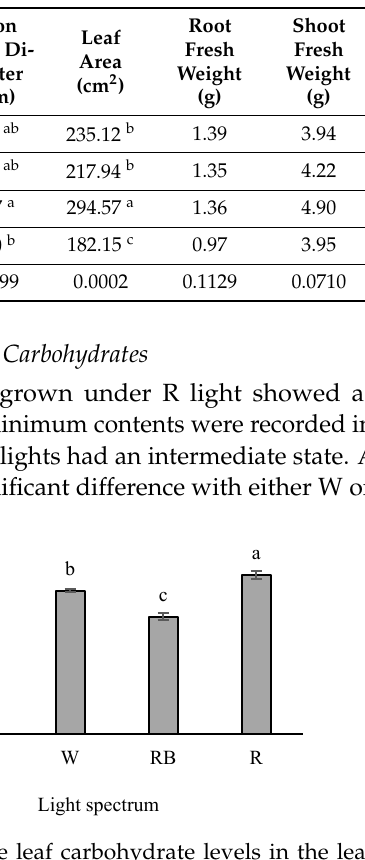
Figure 2. Soluble leaf carbohydrate levels in the leaves of grafted tomato seedlings exposed to different light qualities (including white (W; 35% B, 49% intermediate spectra, 16% R) light as control, blue (B), red (R), and a combination of red (68%) and blue (RB) (see the correspondence spectrum in Figure 1)), with 75 ± 5 µ mol m − 2 s − 1 PPFD for 20 days. Columns with the same letters are not significantly different at p ≤ 0.05, according to Duncan’s multiple range tests. Bars represent the mean value of three replications ± SEM.